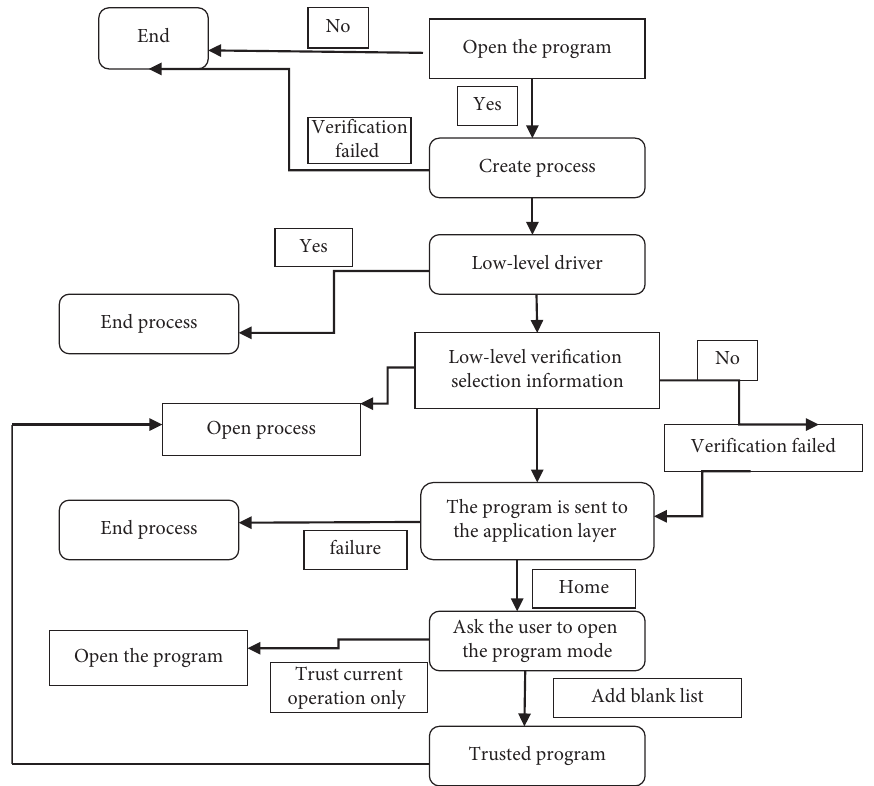
Figure 3: Process security protection operation